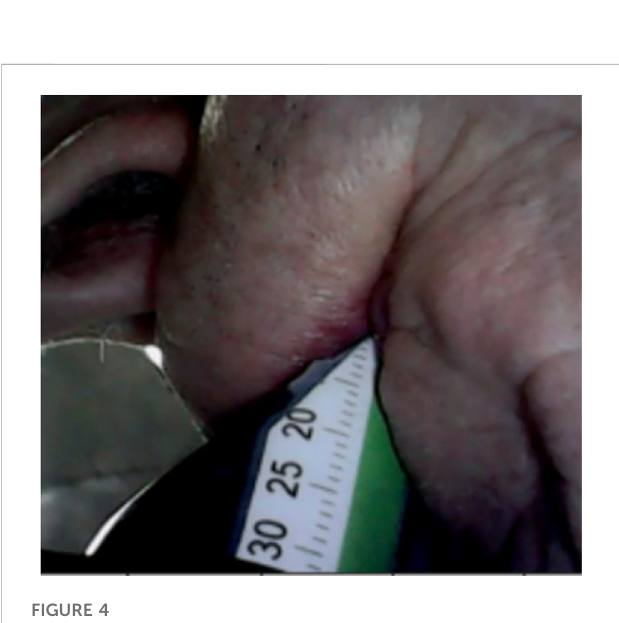
FIGURE 4 Sample frame from the mouthpiece camera during human performance. The mm scale and green target are glued to the clarinet